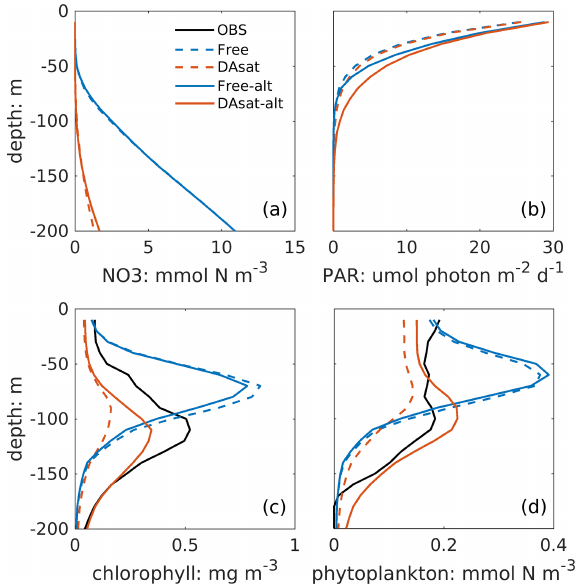
Figure 9. Mean vertical profiles of nitrate, light intensity (photo- synthetically active radiation, PAR), chlorophyll, and phytoplank- ton within the center of the newly detached Loop Current eddy from the Free run, the DAsat run, the Free-alt run, and the DAsat-alt